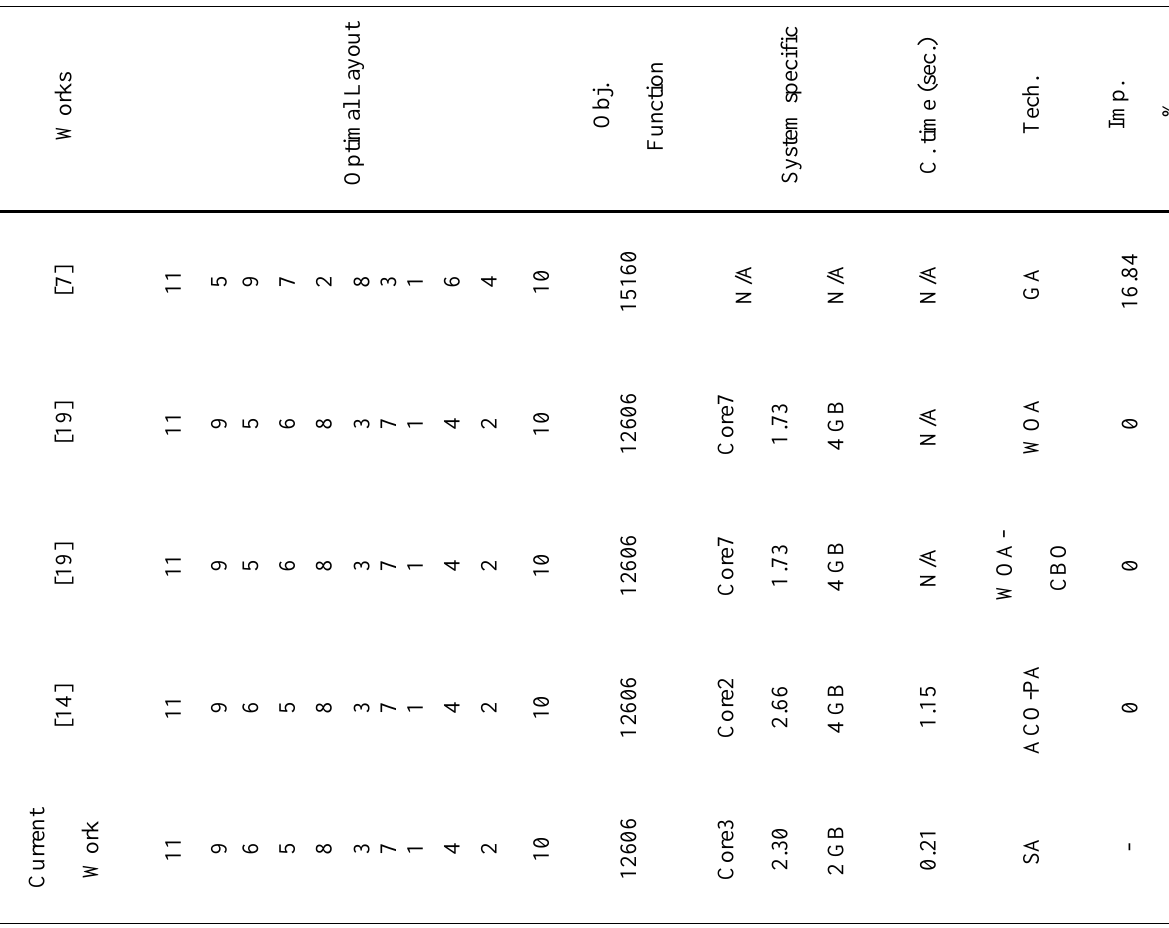
Table 10. A comparison between the results of the current work and previous papers in UA-CSLP case